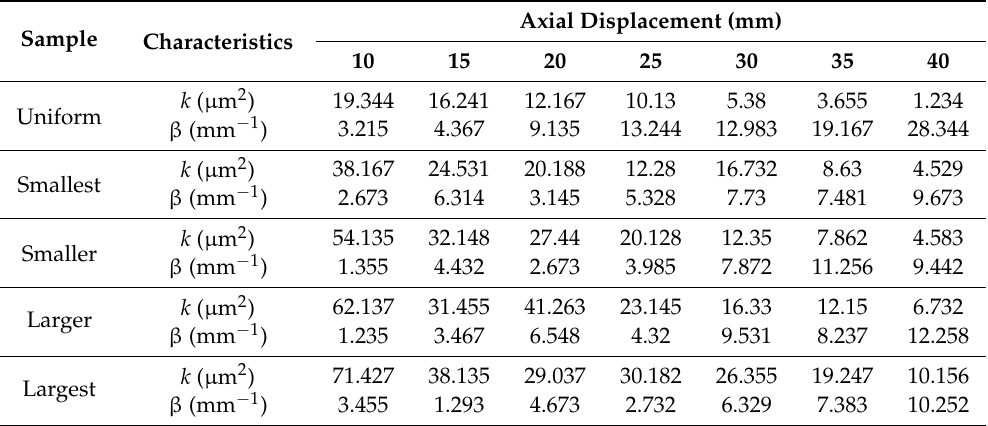
Table 4. Non-Darcy flow characteristics during